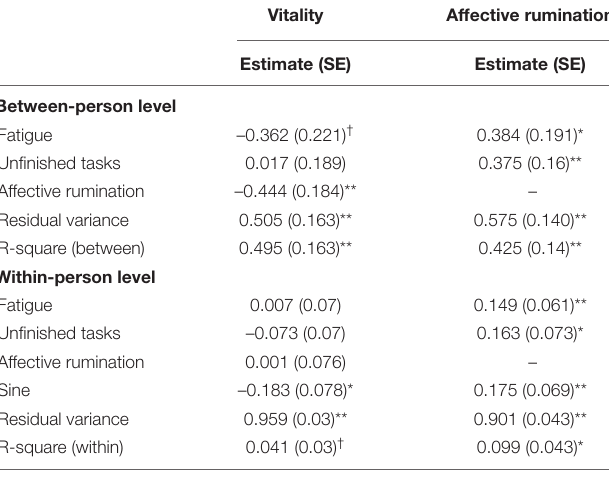
TABLE 3 | Correlations and estimates of predictors in the multilevel path